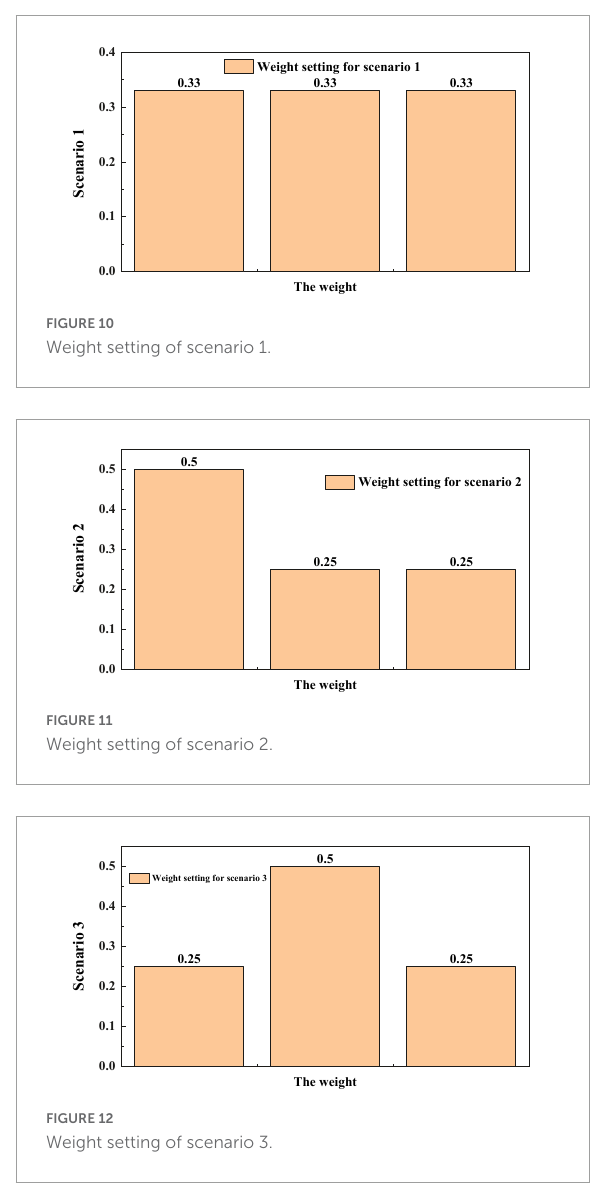
FIGURE12 Weight setting of scenario 3.